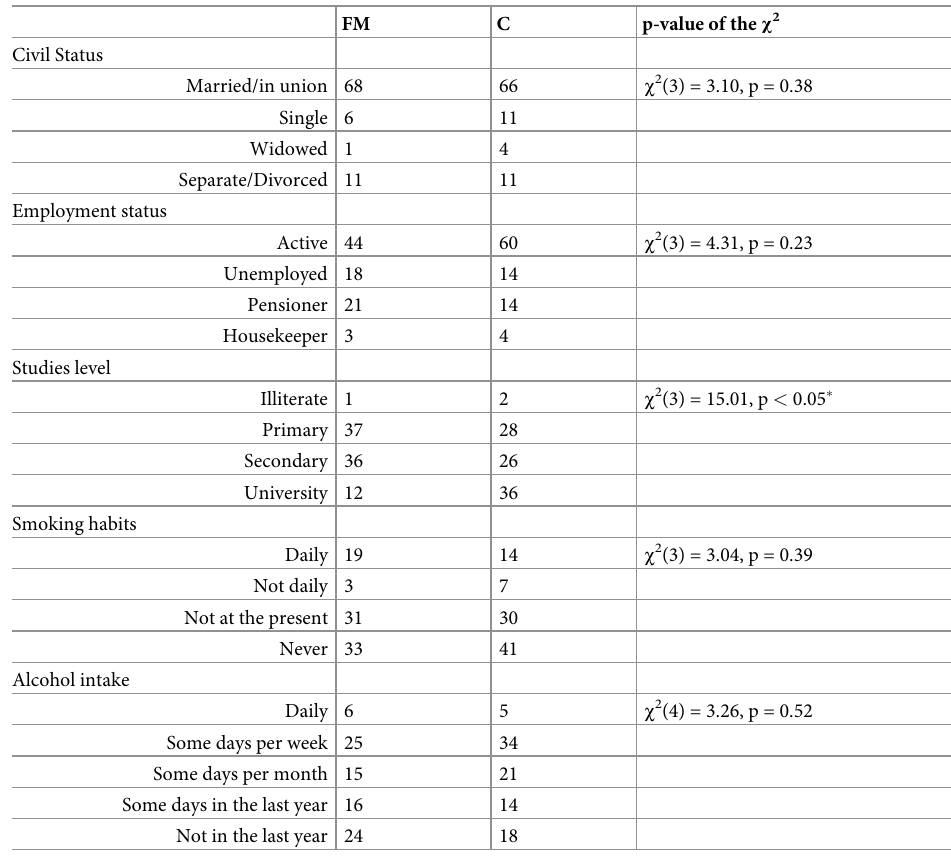
Table 1. Demographic data of the